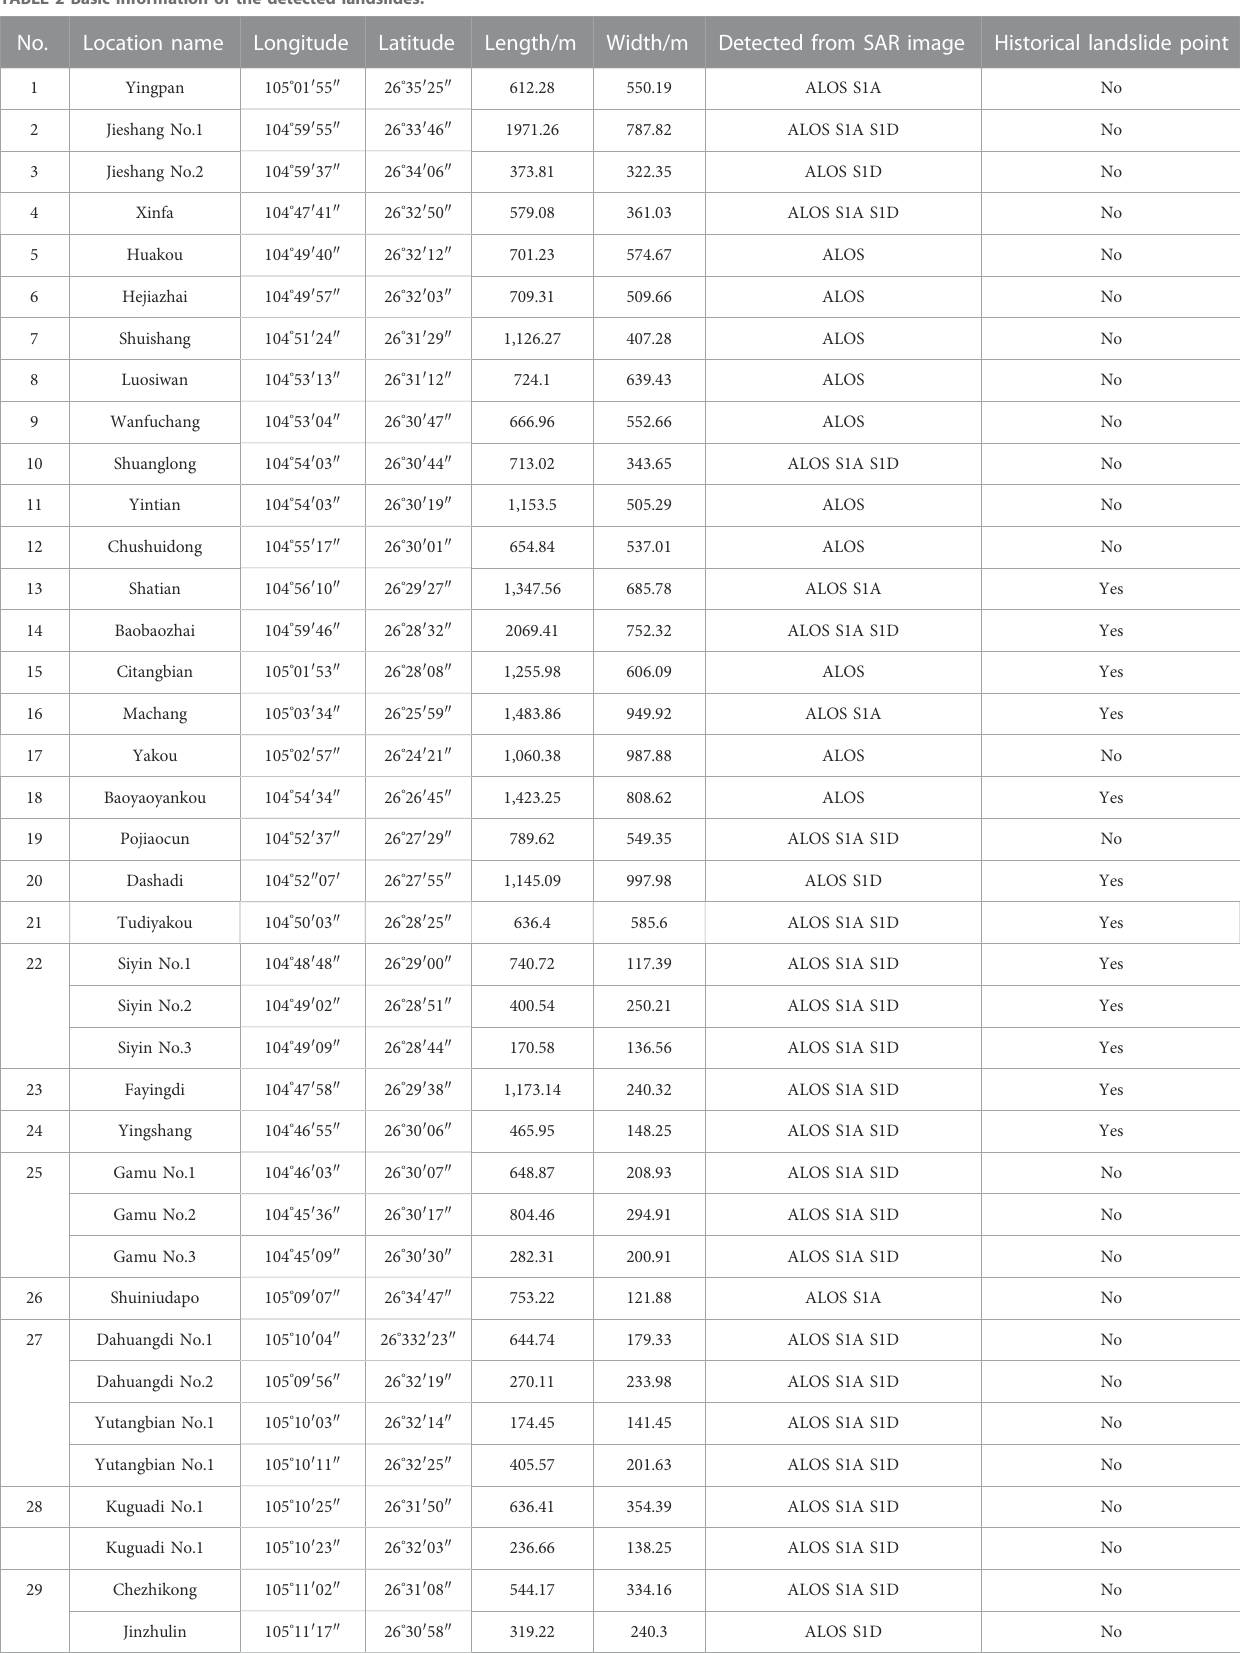
TABLE 2 Basic information of the detected landslides.*